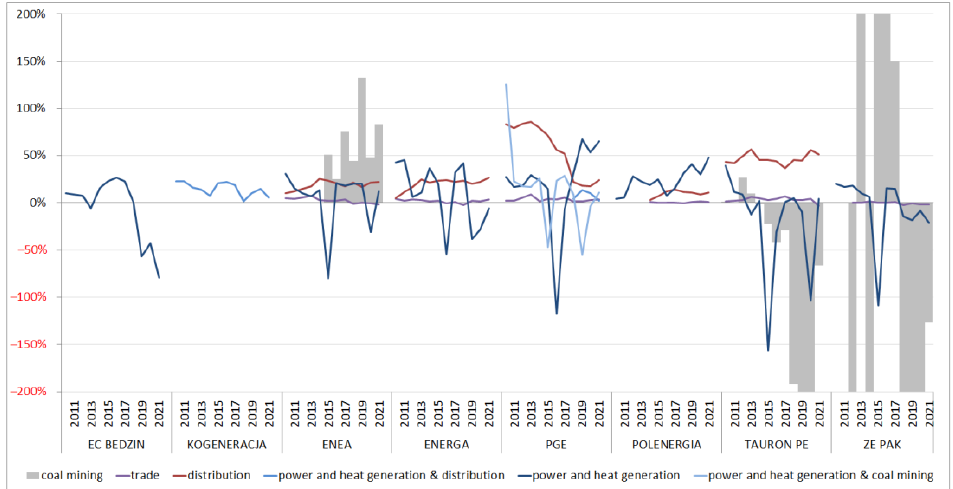
Figure 9. Operating margin on sales in the surveyed energy companies within main business segments. Source: own elaboration.